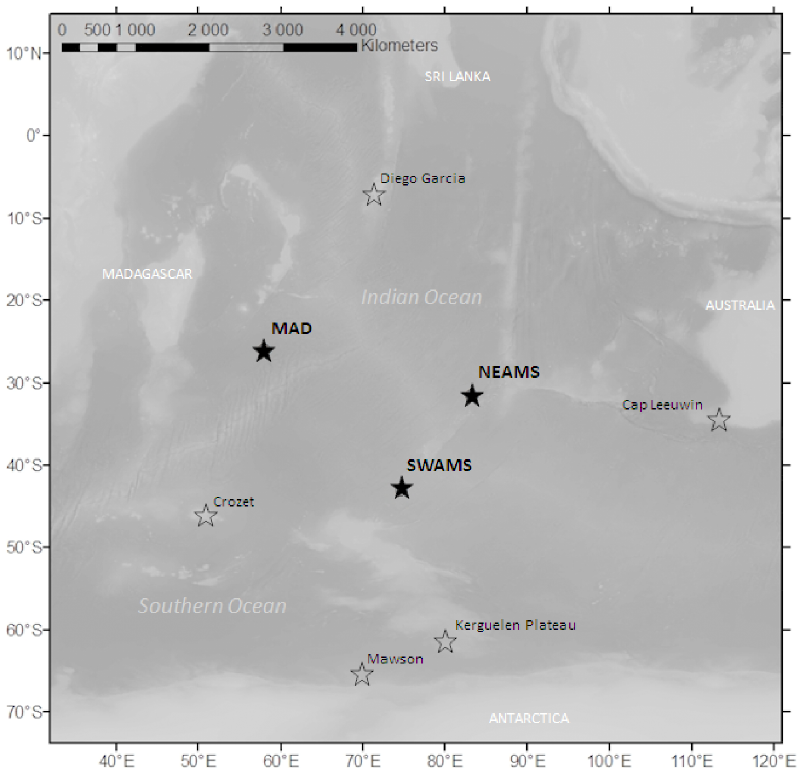
Figure 2. Map of the Indian Ocean. Locations of the hydrophones used in this study are shown as black stars and location of previous recordings of blue whales calls are shown as white stars.